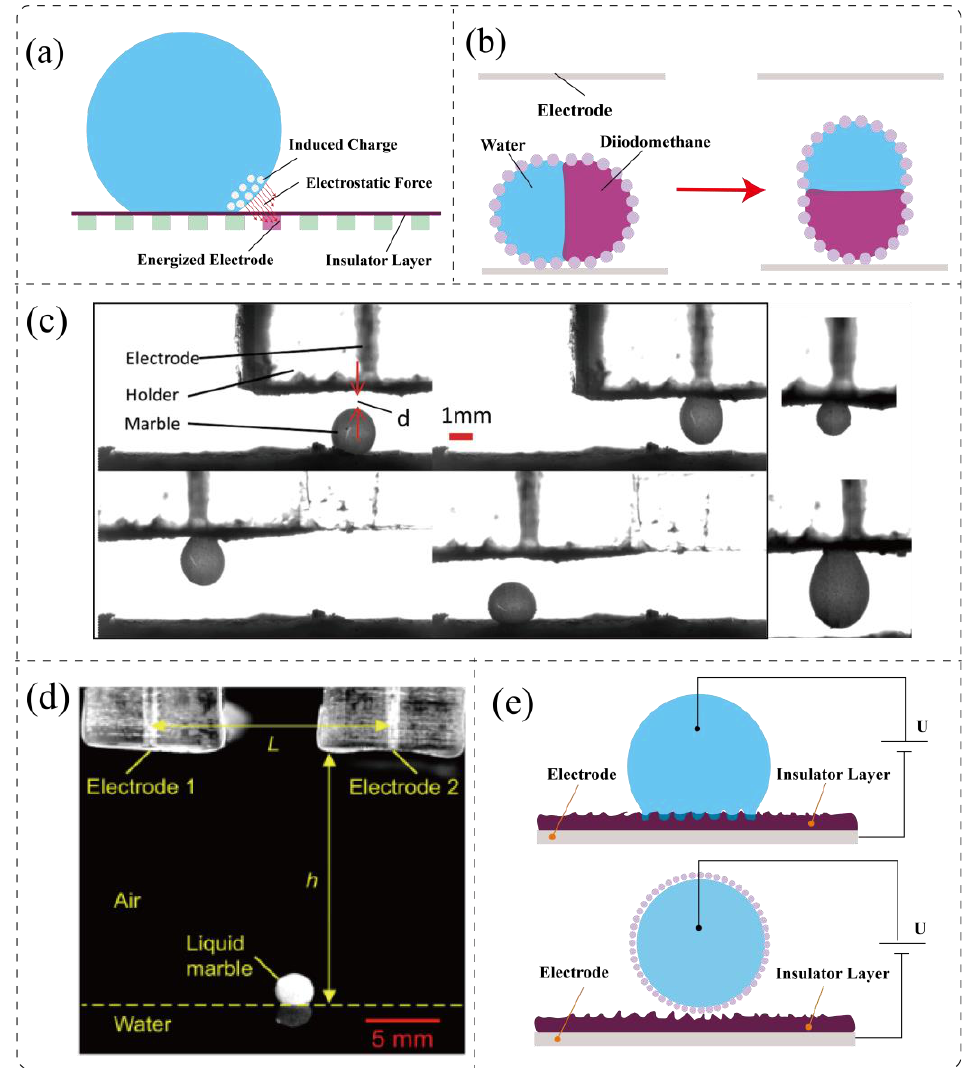
Figure 8. ( a ) A droplet moving on a hydrophobic insulating substrate under the electrostatic force caused by specific energized electrodes. ( b ) Schematic of a water marble climbing on the methylene iodide marble in an electric field [110]. ( c ) Snapshots of a picking-up and placing process of LMs through dielectrophoretic force [111] (Reproduced with permission from Springer Nature, 2018). ( d ) The positioning of a floating LM by the dielectrophoretic force [113] (Reproduced with permission from Springer Nature, 2019). ( e ) The comparison of a droplet and an LM actuated by EWOD, re- spectively.